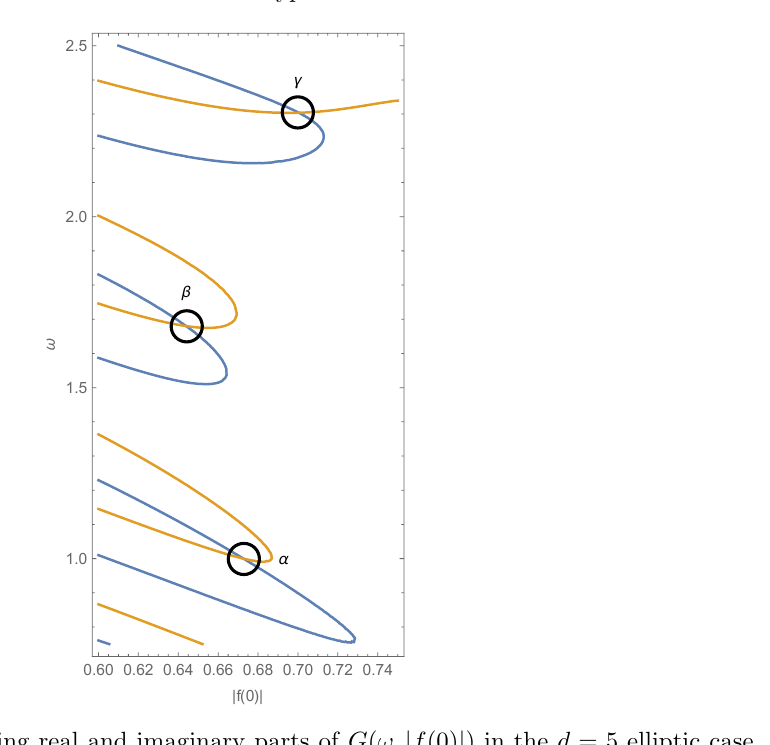
Figure 7 . Pro(cid:12)le of the (cid:11) solution of the hyperbolic class in four dimensions.